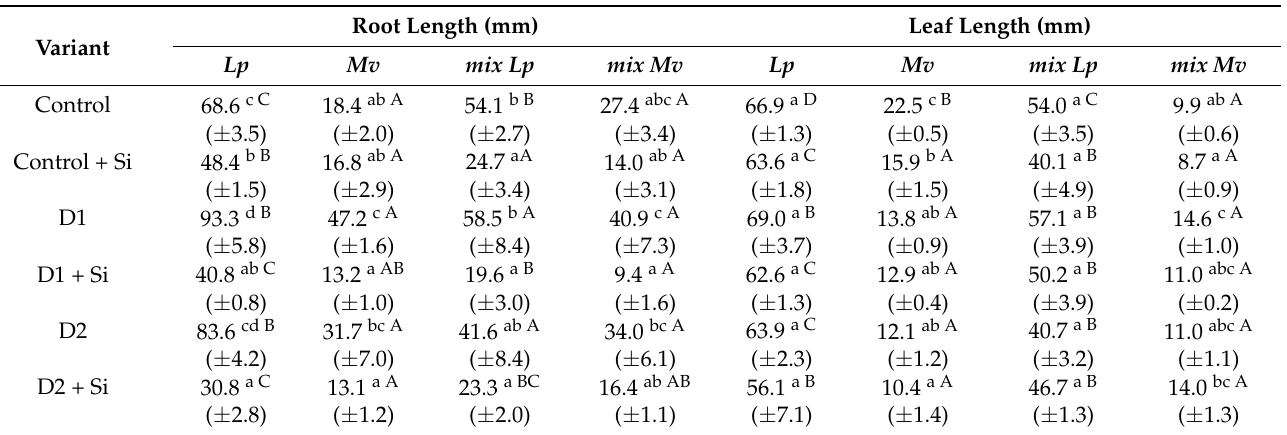
Table 4. Effects of different variants of drought conditions on root and leaf length of Lolium perenne ( Lp ) and Medicago x varia ( Mv ).